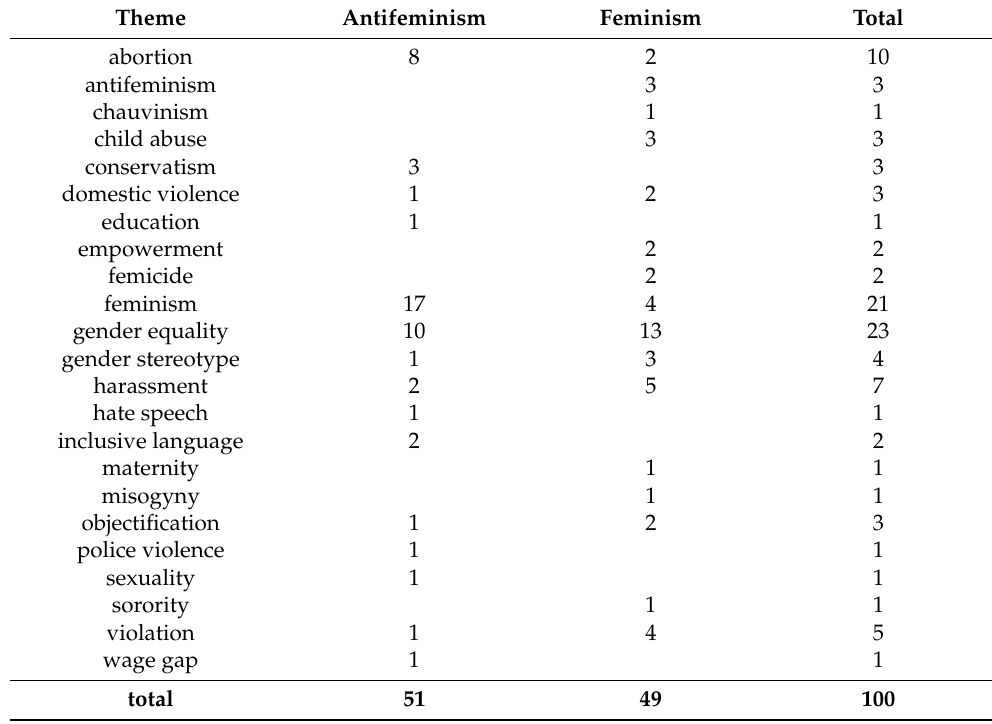
Table 1. Themes identified in the analysis corpus (absolute